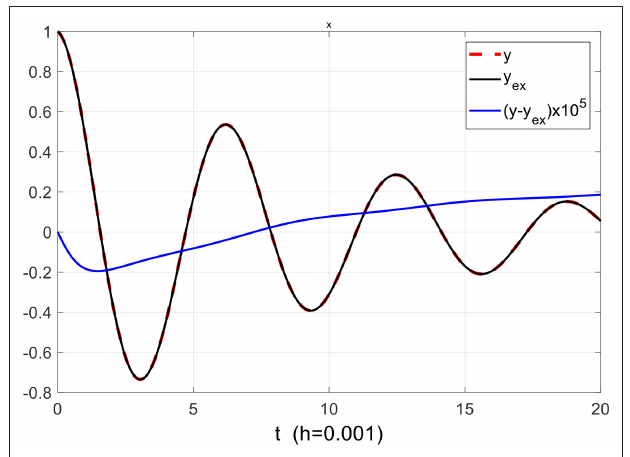
FIGURE 6 | Solution y and error y